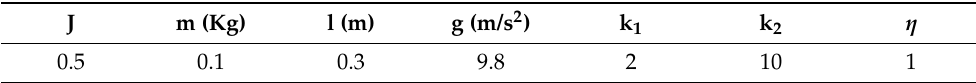
Table 3. Single-Link Robot and Controller Parameters.